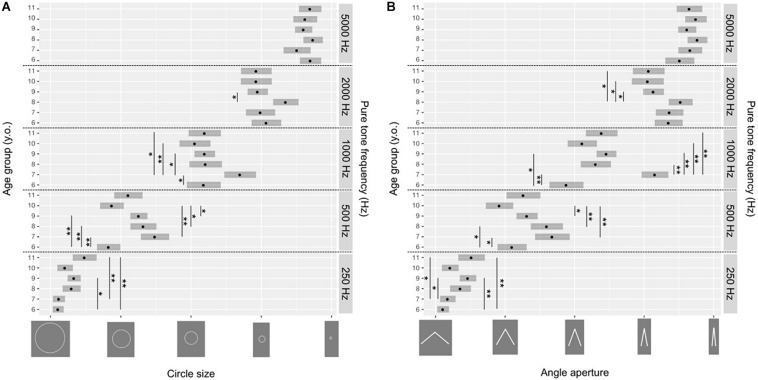
Results of all participants in the circle (A) and angle (B) condition. Each data point indicates the average of the probability distributions of each response rating corresponding to the circle (A; see Table 1) and angle (B; see Table 2) response options. Error bars indicate the 95% confidence interval. ∗p < 0.05, ∗∗p < 0.01 as reported in Table 3 (for the circle condition) and Table 4 (for the angle condition).